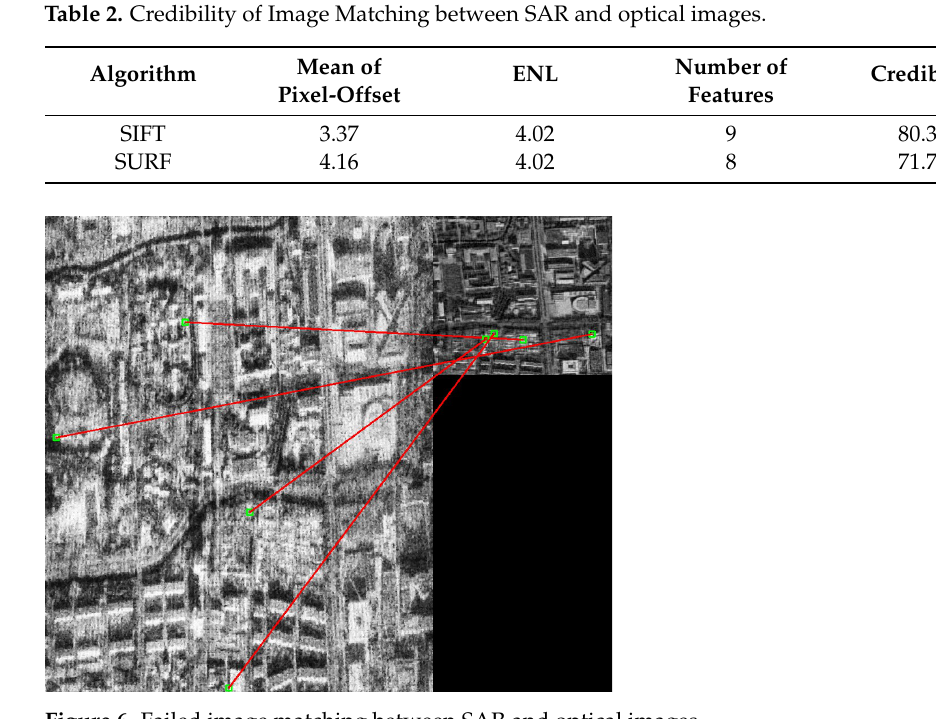
Figure 6. Failed image matching between SAR and optical